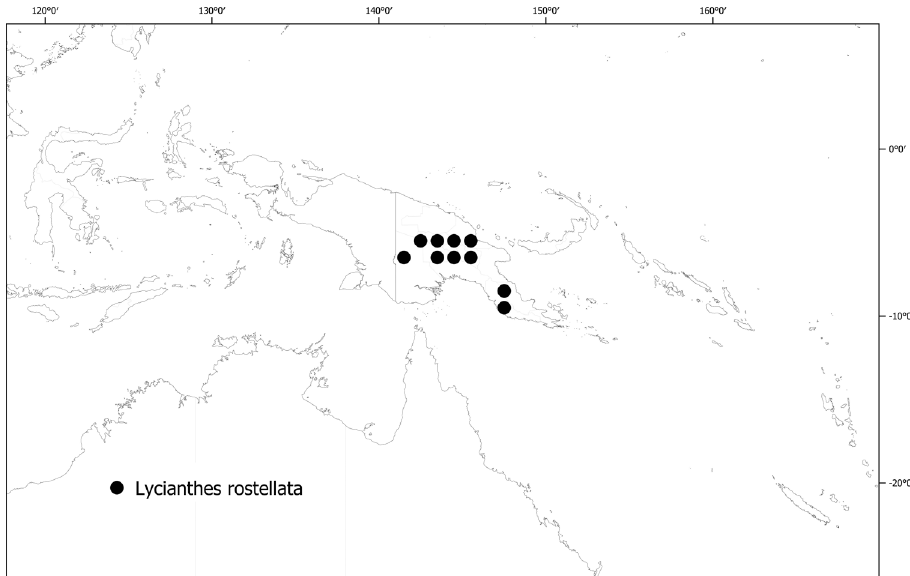
Figure 47. Distribution of Lycianthes rostellata